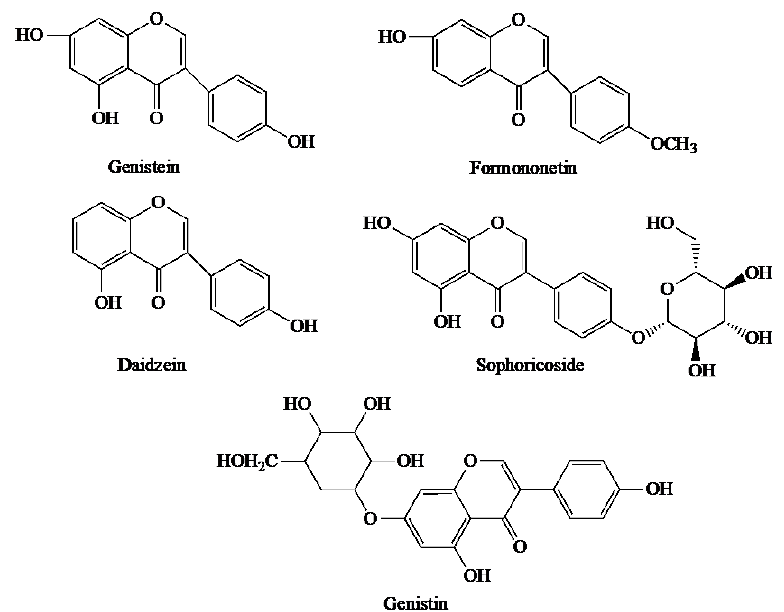
Figure 6. Chemical structures of 5 important BCA metabolites.